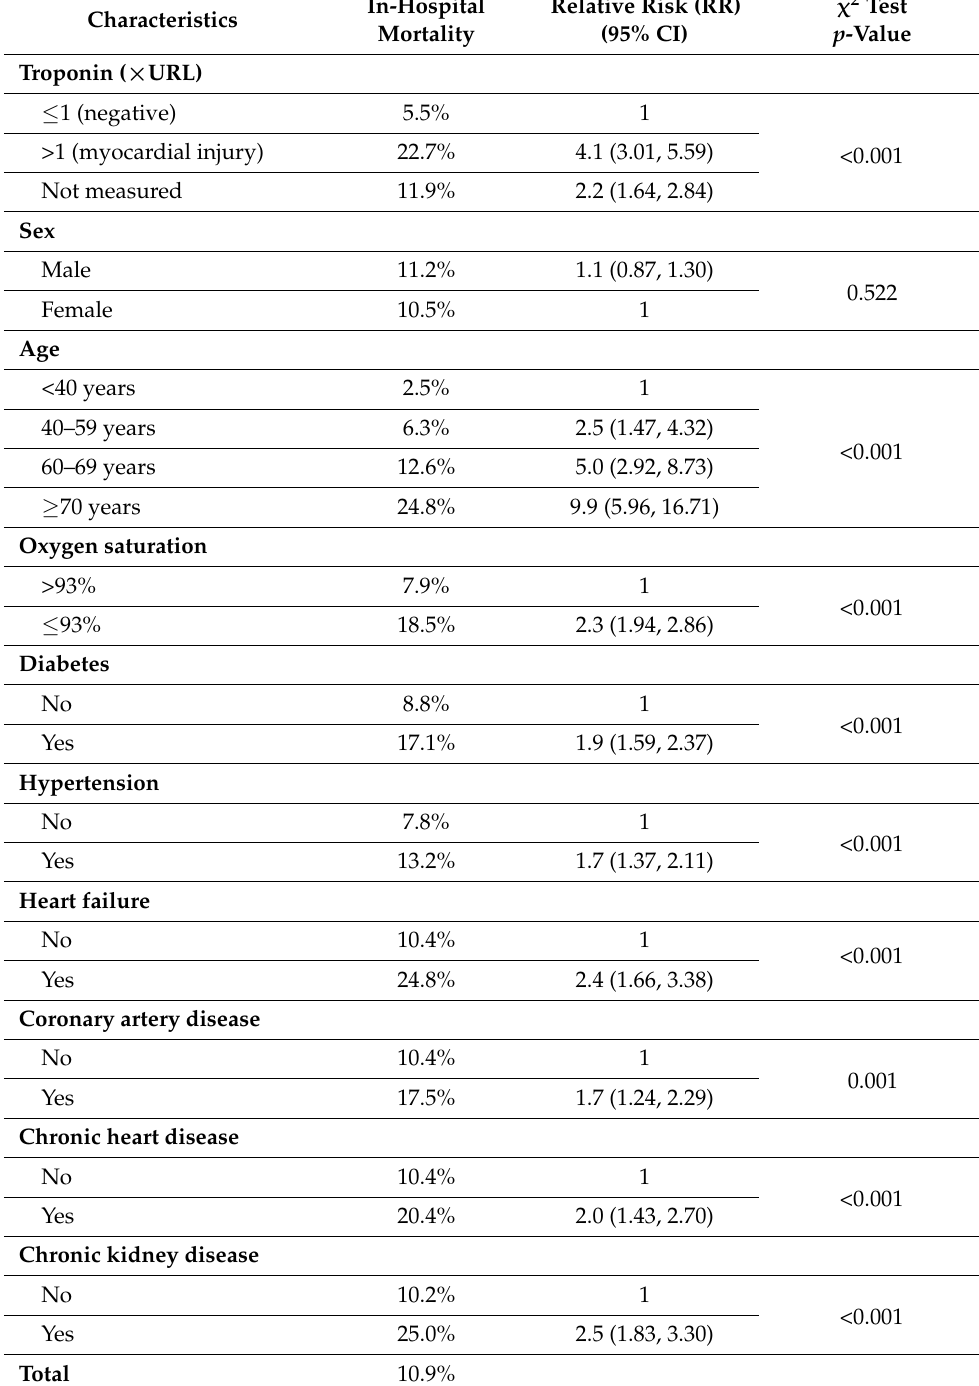
Table 3. In-hospital mortality and its relative risk according to baseline patient characteristics ( n =